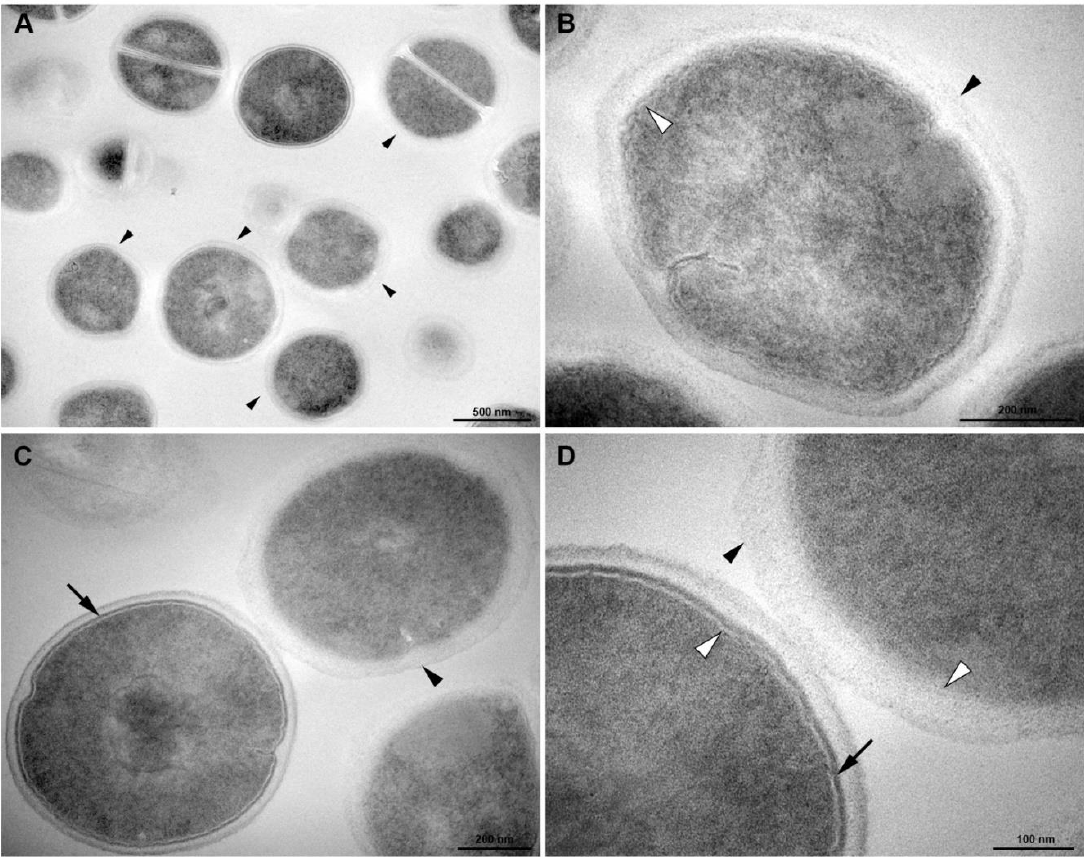
Figure 7. Transmission electron microscopy of S. aureus treated with antibiotics (Menadione MIC/4). ( A ) General view: some cells display altered cell wall without a tripartite-layers structure (black arrowheads). ( B ) Detailed view: the cell has no visible electron-dense inner thin zone of the cell wall (black arrowhead). White arrowhead indicates the plasma membrane. ( C ) Left cell display the normal tripartite cell wall with a heavily stained inner thin zone (arrow), whereas this electron-dense layer is not seen on the right cell (black arrowhead). ( D ) Inset of the Figure C. White arrowhead, plasma membrane. Bars: A: 500 nm; B,C: 200 nm; D: 100 nm.